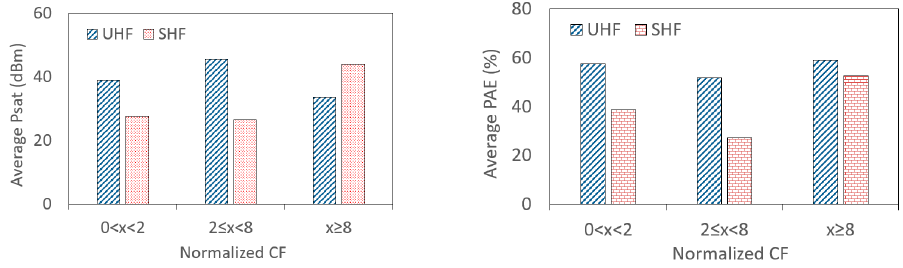
Figure 5. Plot of average P sat and PAE against normalized CF for different applications.